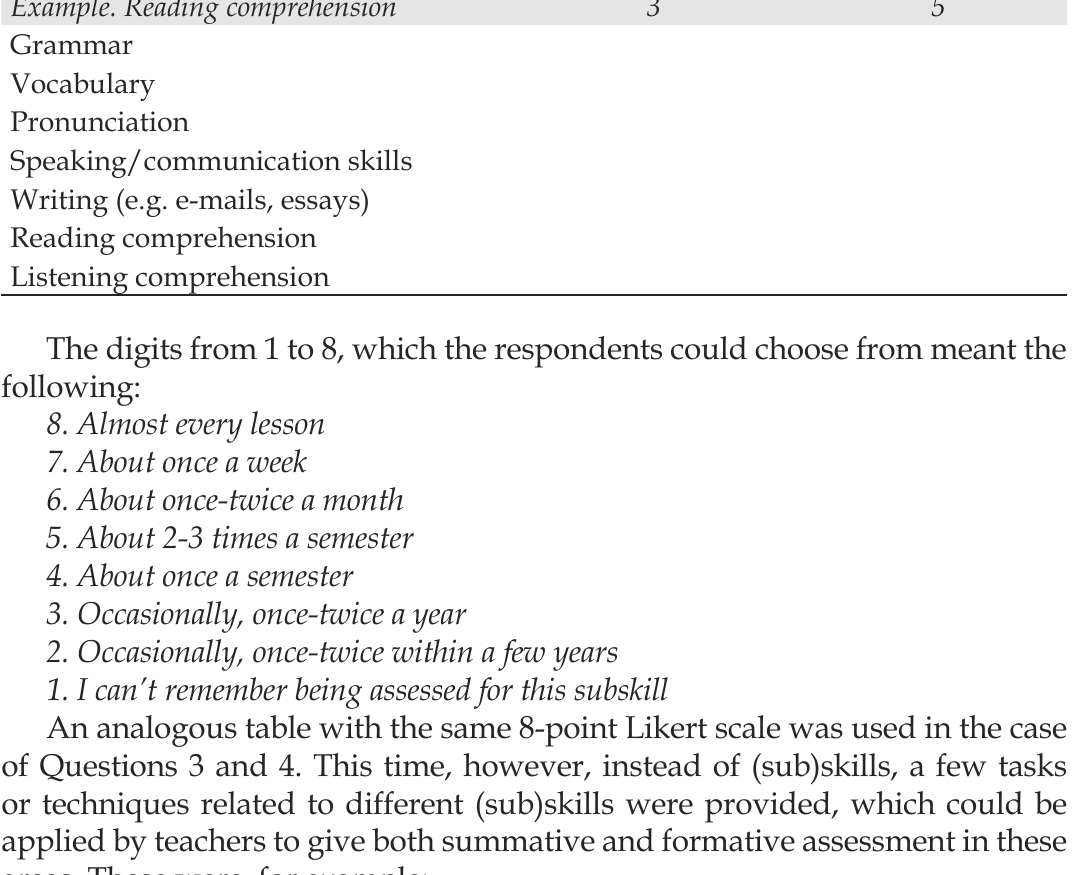
The table used by the respondents to mark the frequency of being provided with summative and formative assessment Final (Matura) form Example. Reading